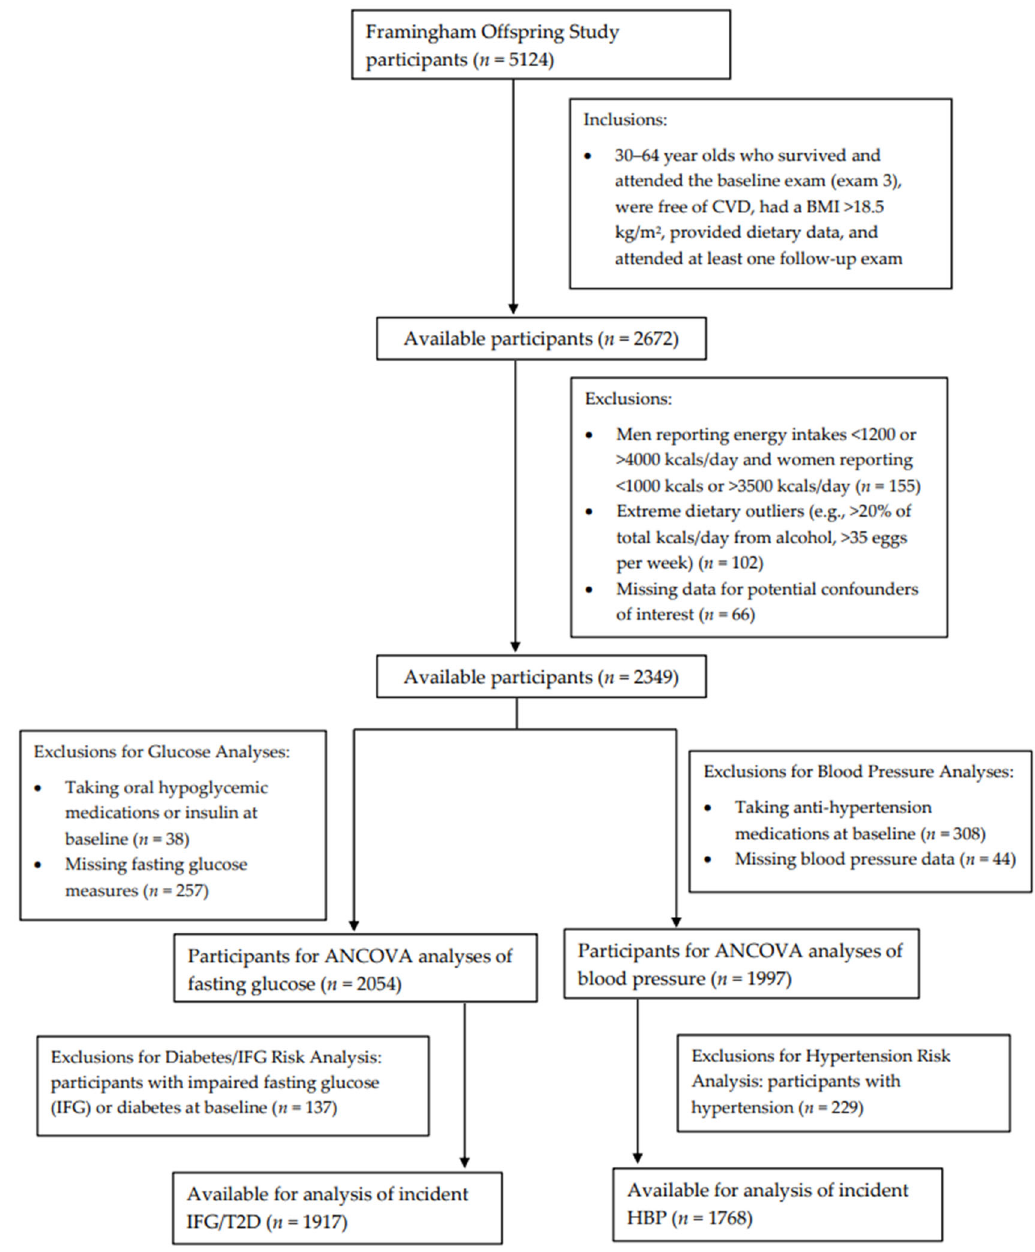
Figure 1. Flowchart of study participants.